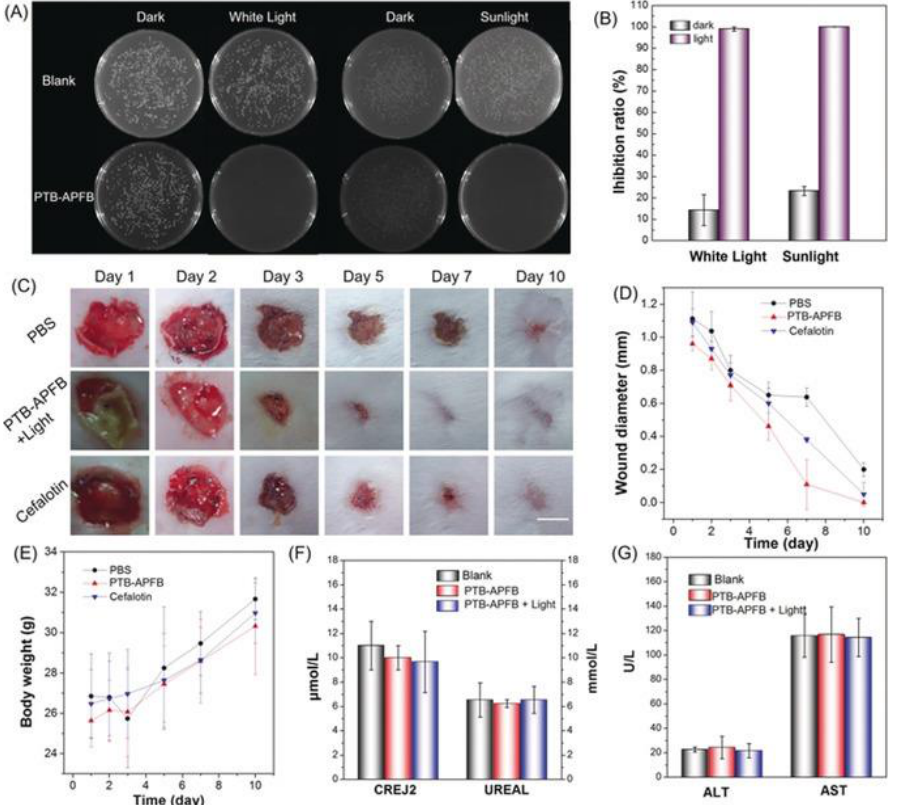
Figure 23. ( A ) Photographs of NB agar plate and ( B ) biocidal activity of S. aureus with PTB-APFB treatment in dark and under white light and sunlight. ( C ) Photographs of the S. aureus -infected skin of mice during treatment with the different formulations, and ( D ) the size of the infected area as well as ( E ) the body weights of the mice. Scale bar = 1 cm. ( F ) Levels of CREJ2 and UREAL (biomarkers), and ( G ) ALT and AST (liver function biomarkers) in blood samples from mice with different treatments. Reproduced with permission from reference [157]. Copyright 2020, John Wiley and Sons.